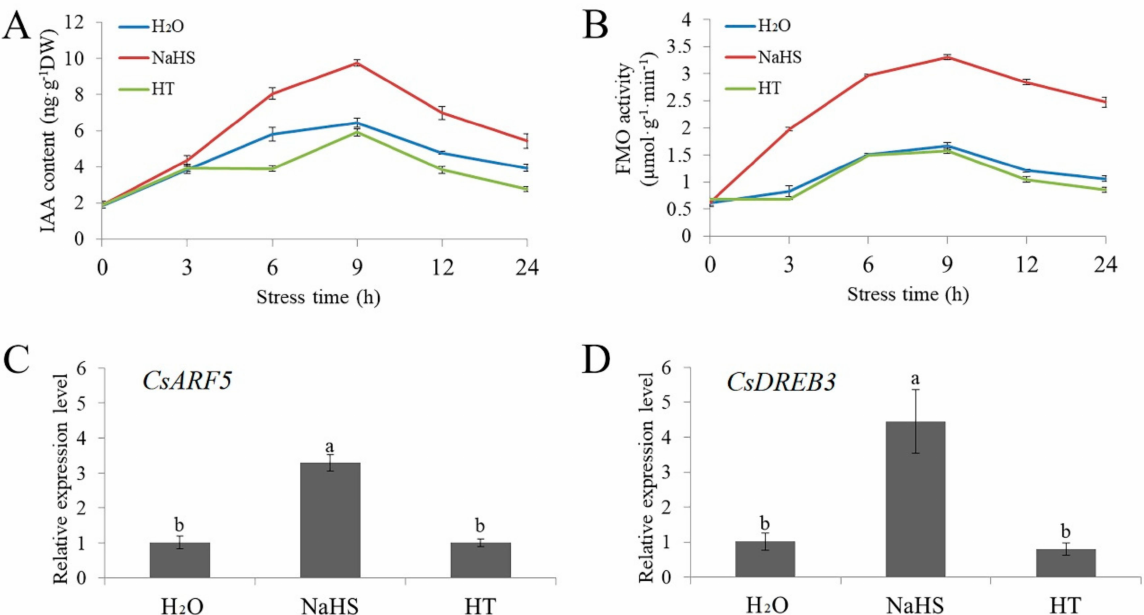
Figure 3. NaHS treatment affects IAA levels in cucumber. ( A ) The IAA content of cucumber seedlings treated with NaHS or HT under cold stress treatment for 24 h. ( B ) The FMO activity of cucumber seedlings treated with NaHS or HT under cold stress treatment for 24 h. ( C ) Expression of the CsARF5 gene in cucumber seedlings treated with NaHS or HT under cold stress treatment for 6 h. ( D ) Expression of the CsDREB3 gene in cucumber seedlings treated with NaHS or HT under cold stress treatment for 6 h. qRT- PCR was performed simultaneously with three biological replicates and three technical replicates. The value of 0 h was used as the reference and was set to 1. Error bars denote standard deviations. Different letters indicate significant differences ( p < 0.05) based on Duncan’s multiple range